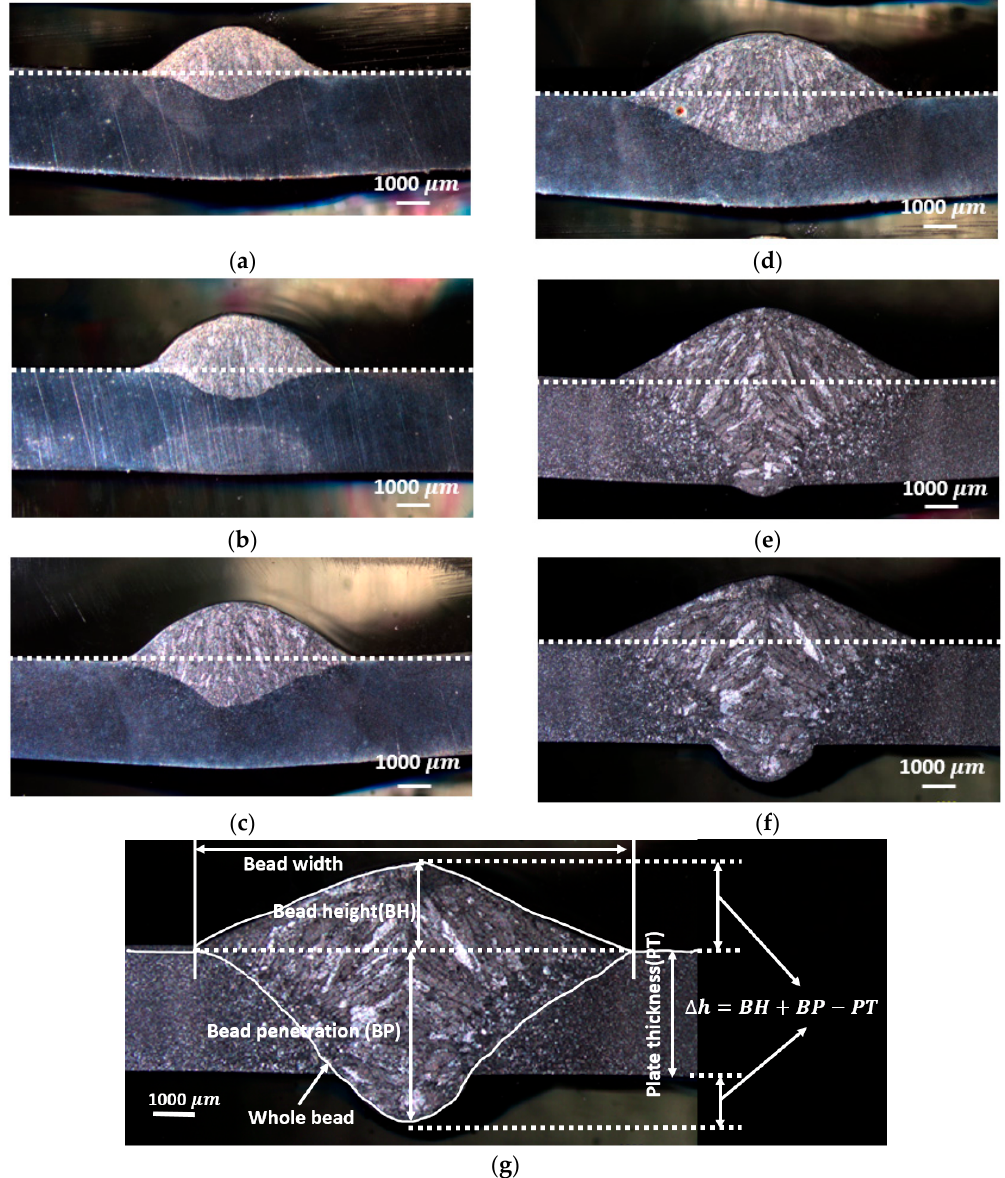
Figure 5. The macrophotographs of welds ( a ) P1, ( b ) P2, ( c ) P3, ( d ) P4, ( e ) P5, ( f ) P6 and ( g ) description of bead profile. Table 4. The summary of weld dimensions as a result of different weld heat inputs.